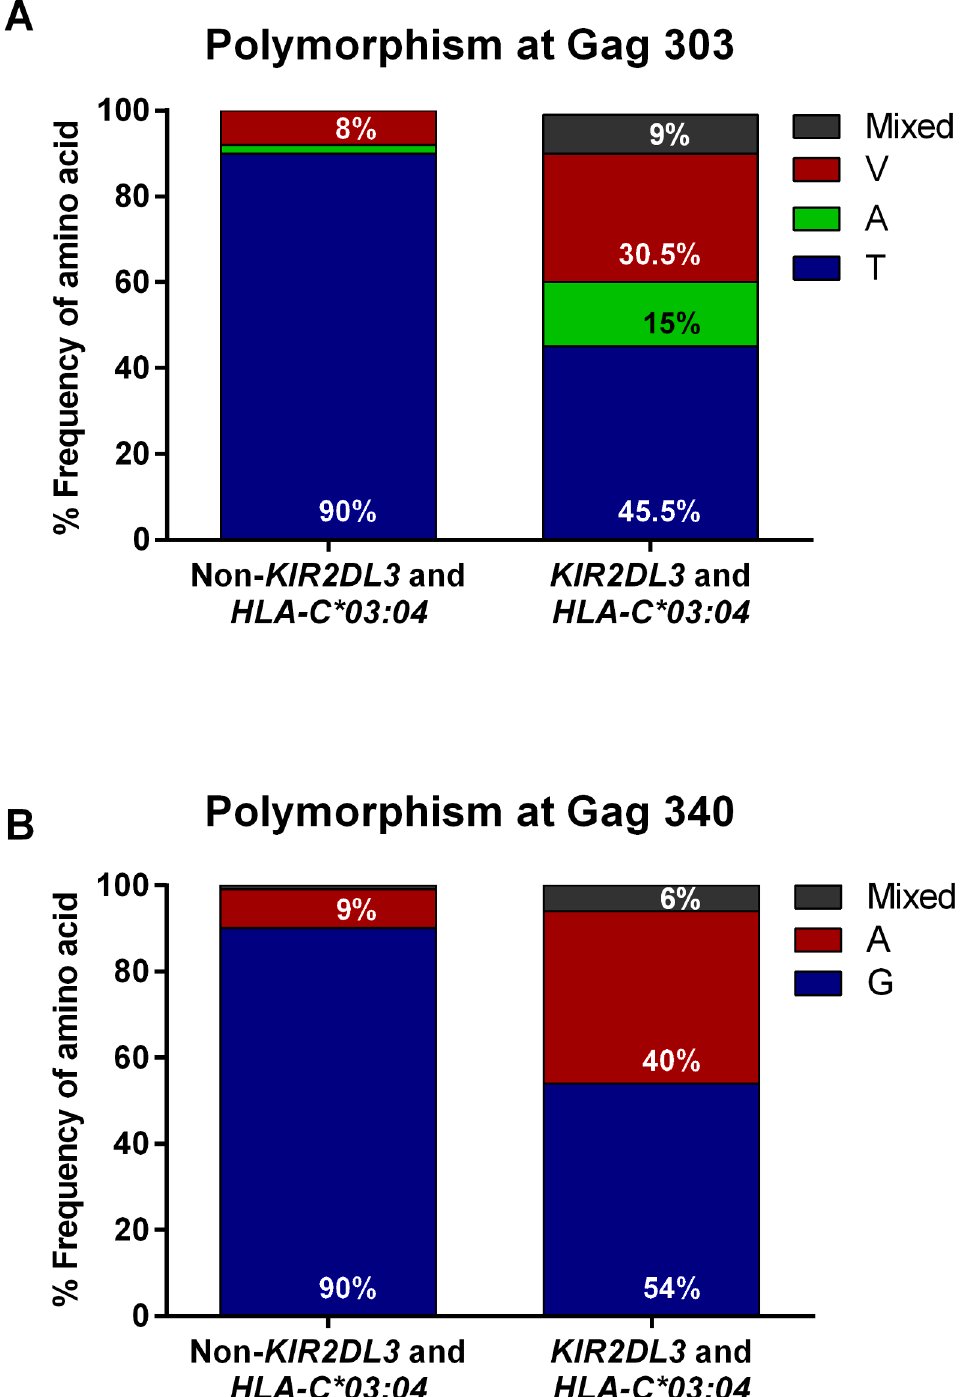
Fig 1. Distribution of frequencies of wild-type and variant Gag sequences in viruses from KIR2DL3+/HLA-C * 03 : 04+ individuals compared to individuals not possessing the combined KIR2DL3/HLA-C * 03 : 04 genotype. (A) A valine (V) at amino acid position 303 of HIV-1 Gag was significantly ( p < 0.001, Fisher`s exact test) overrepresented in KIR2DL3+/HLA-C * 03 : 04+ individuals ( n = 33) compared to individuals not possessing this combined genotype (non- KIR2DL3 and HLA-C * 03 : 04 , n = 348), 90% of whom had virus with the consensus sequence wild-type threonine (T) in that position ( n = 312). Furthermore, an alanine (A) variant at position Gag 303 was present in five of the 33 individuals in the KIR2DL3+/HLA-C * 03 : 04+ group (15%). The percentage of individuals whose virus showed mixed residues at position Gag 303 was 0% in KIR2DL3 − /HLA-C * 03 : 04 − individuals and 9% in KIR2DL3+/HLA-C * 03 : 04+ individuals. (B) An alanine (A) at position 340 of HIV-1 Gag was significantly ( p < 0.001, Fisher ’ s exact test) overrepresented in KIR2DL3+/HLA-C * 03 :